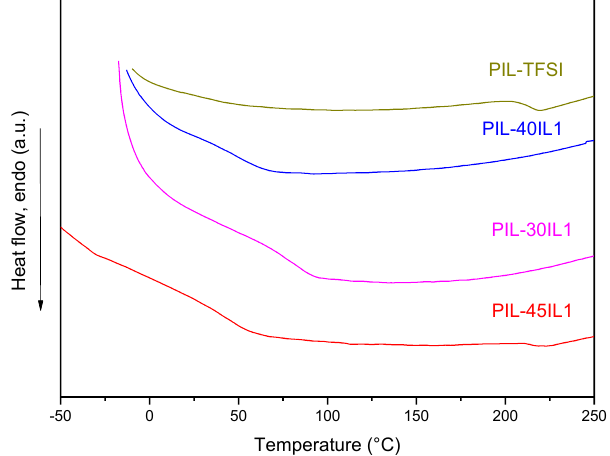
Figure 8. DSC curves of neat PIL and PIL-IL1 composite membranes.